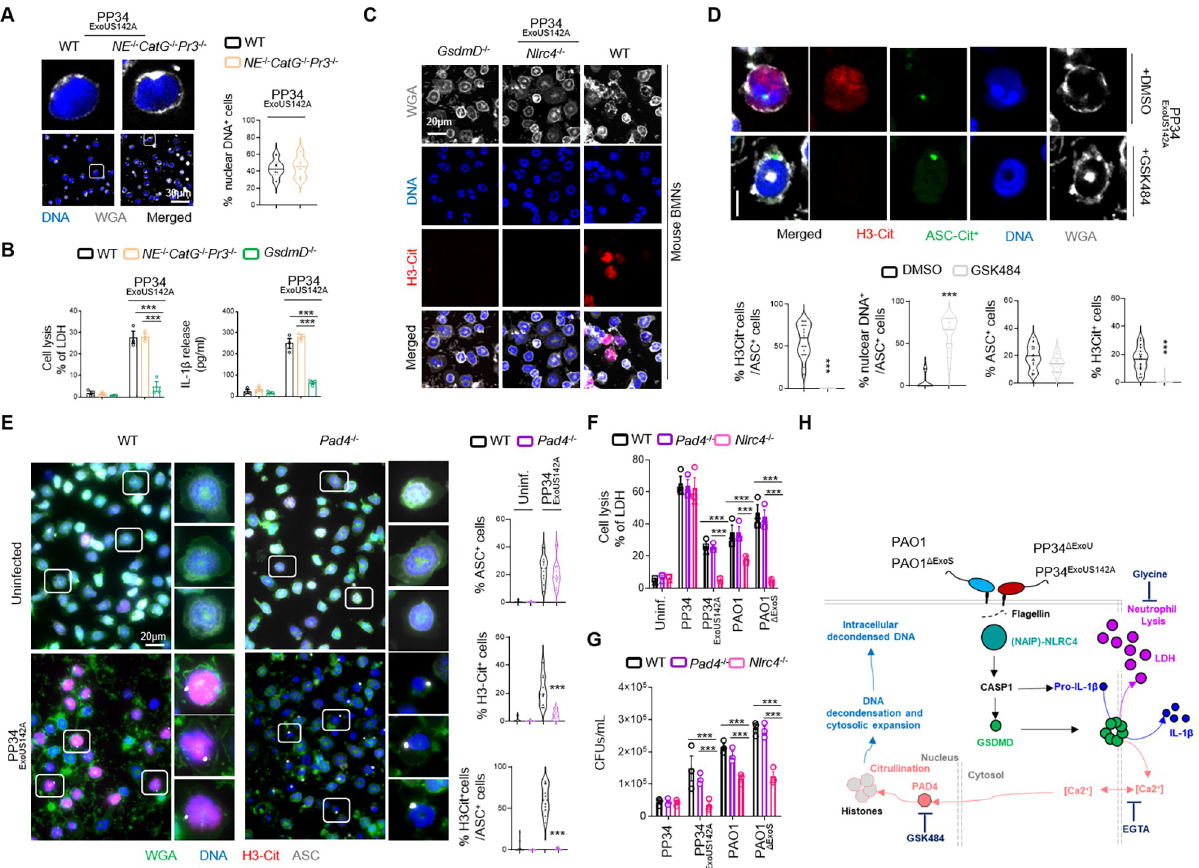
Fig 4. Canonical inflammasome activation-induced DNA decondensation requires PAD4-dependent Histone Citrullination and occurs independently of cell shrinkage. A. Confocal microscopy observations and quantifications of WT and NE -/- CatG -/- Pr3 -/- BMNs infected for 3 hours with P . aeruginosa pyroptotic strain PP34 ExoUS142A (MOI 2) and harboring decondensed DNA and plasma membrane (WGA). Nucleus (blue) was stained with Hoechst; plasma membrane is in grey (WGA staining). For quantifications, the percentage of cells with nuclear DNA was determined by quantifying the ratios of cells positives for decondensed DNA on nuclear DNA. 6 fields from n = 3 independent experiments were analyzed. Scale bar 30 μ m. ��� p � 0.001, T-test with Bonferroni correction. B. Measure of cell lysis (release of LDH) and IL-1 β release in WT, NE -/- CatG -/- Pr3 -/- and GsdmD -/- murine Bone Marrow Neutrophils (BMNs) infected for 3 hours with Pseudomonas aeruginosa pyroptotic strain PP34 ExoUS142A (MOI 2). ��� p � 0.001, Two-Way Anova with multiple comparisons. Values are expressed as mean ± SEM. Graphs show combined values from three independent experiments. C. Confocal microscopy observations of WT, Nlrc4 -/- and GsdmD -/- BMNs infected for 3 hours with P . aeruginosa pyroptotic strain PP34 ExoUS142A (MOI 2) and harboring Citrullinated Histone 3 (H3-Cit), decondensed DNA (Hoechst) and plasma membrane (WGA). Nucleus (blue) was stained with Hoechst; Citrullinated Histone-3 is in red (anti H3-Cit); plasma membrane is in grey (WGA staining). Scale bar 20 μ m. Images are representative of one experiment performed three times with at least 150 neutrophils observed/ experiment. D. Confocal microscopy observations and quantifications of the percentage of cells harboring ASC complexes, H3Citrullination and nuclear/decondensed DNA in WT-ASC-Citrine + BMNs infected for 3 hours with PP34 ExoUS142A in presence/absence of the PAD4 inhibitor GSK484 (10 μ M). Nucleus (blue) was stained with Hoechst; Histone- 3 Citrullination is in red (Anti-H3Cit staining); plasma membrane is in grey (WGA staining). Scale bar 10 μ m. For quantifications, the percentage of cells with ASC complexes, nuclear DNA or positives for H3Cit (H3-Cit + ) was determined by quantifying the ratios of cells positives for ASC speckles, nuclear DNA or H3Cit. At least 10 fields from n = 3 independent experiments were analyzed. Values are expressed as mean ± SEM. ��� p � 0.001, T-test with Bonferroni correction. E. Confocal microscopy observations and quantifications of WT and Pad4 -/- BMNs infected for 3 hours with P . aeruginosa pyroptotic strain PAO1 Δ ExoS (MOI 10) and harboring ASC complexes, Citrullinated Histone 3 (H3-Cit), decondensed DNA and plasma membrane (WGA). Nucleus (blue) was stained with Hoechst; Histone-3 Citrullination is in red (Anti-H3Cit staining); plasma membrane is in green (WGA staining), ASC is in grey (Anti-ASC). Scale bar 10 μ m. For quantifications, the percentage of cells with ASC complexes, nuclear DNA or positives for H3Cit (H3-Cit + ) was determined by quantifying the ratios of cells positives for ASC speckles, nuclear DNA or H3Cit. At least 10 fields from n = 3 independent experiments were analyzed. Values are expressed as mean ± SEM. ��� p � 0.001, Two-Way Anova with multiple comparisons. F. Measure of cell lysis (release of LDH) and bacterial killing in WT, Pad4 -/- and Nlrc4 -/- murine Bone Marrow Neutrophils (BMNs) infected for 3 hours with Pseudomonas aeruginosa strains PP34 (MOI 2), PP34 ExoUS142A (MOI 2), PAO1 (MOI 10) or PAO1 Δ ExoS (MOI 10). ��� p � 0.001, Two-Way Anova with multiple comparisons. Values are expressed as mean ± SEM. LDH graph shows combined values from three independent experiments and CFU graph is from one experiment representative of three independent experiments. G. Overview of the different steps induced in neutrophils during NLRC4 inflammasome activation by various Pseudomonas aeruginosa